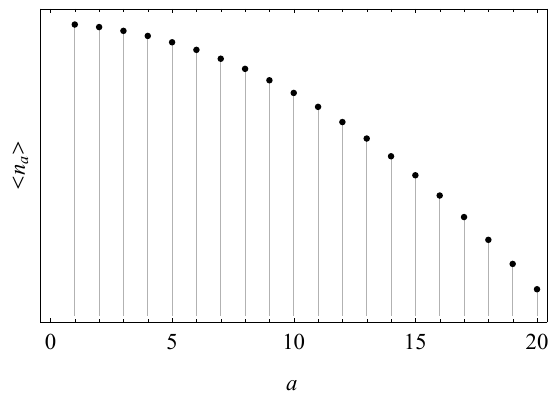
Figure 8. The string condensation VEV h n a i for the rank N = 20 E-string theory. We set m l = 0 and m = πi for the simplicity. One can see that the strings are more condensed near the